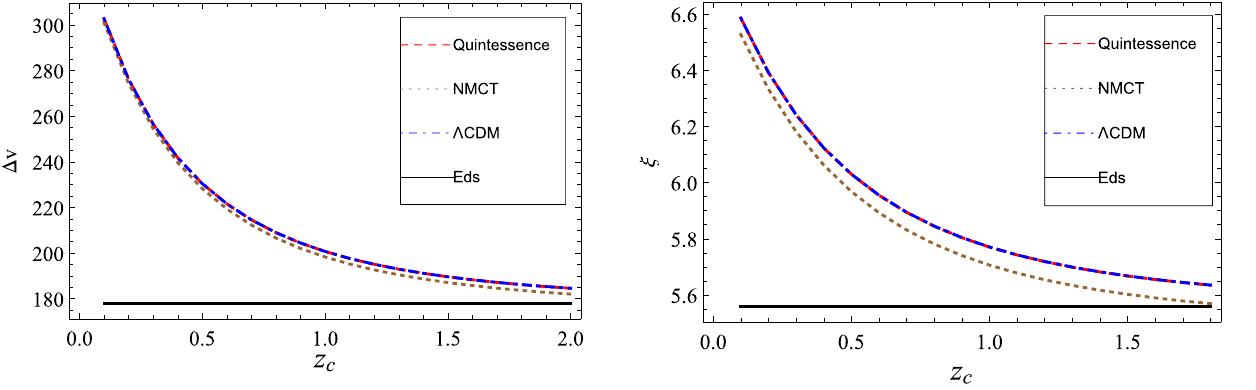
Fig. 6 The evolution of virialized overdensity parameter Δ V versus z c for the Λ CDM , quintessence, NMCT and Eds models